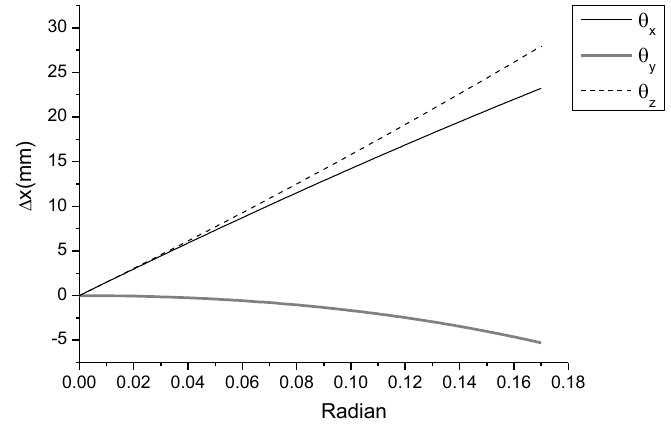
Figure 15. Change in horizontal distance due to rotation around each